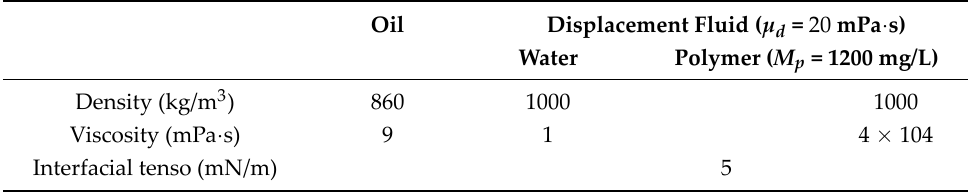
Table 1. Fluid parameters of oil and polymer solution.